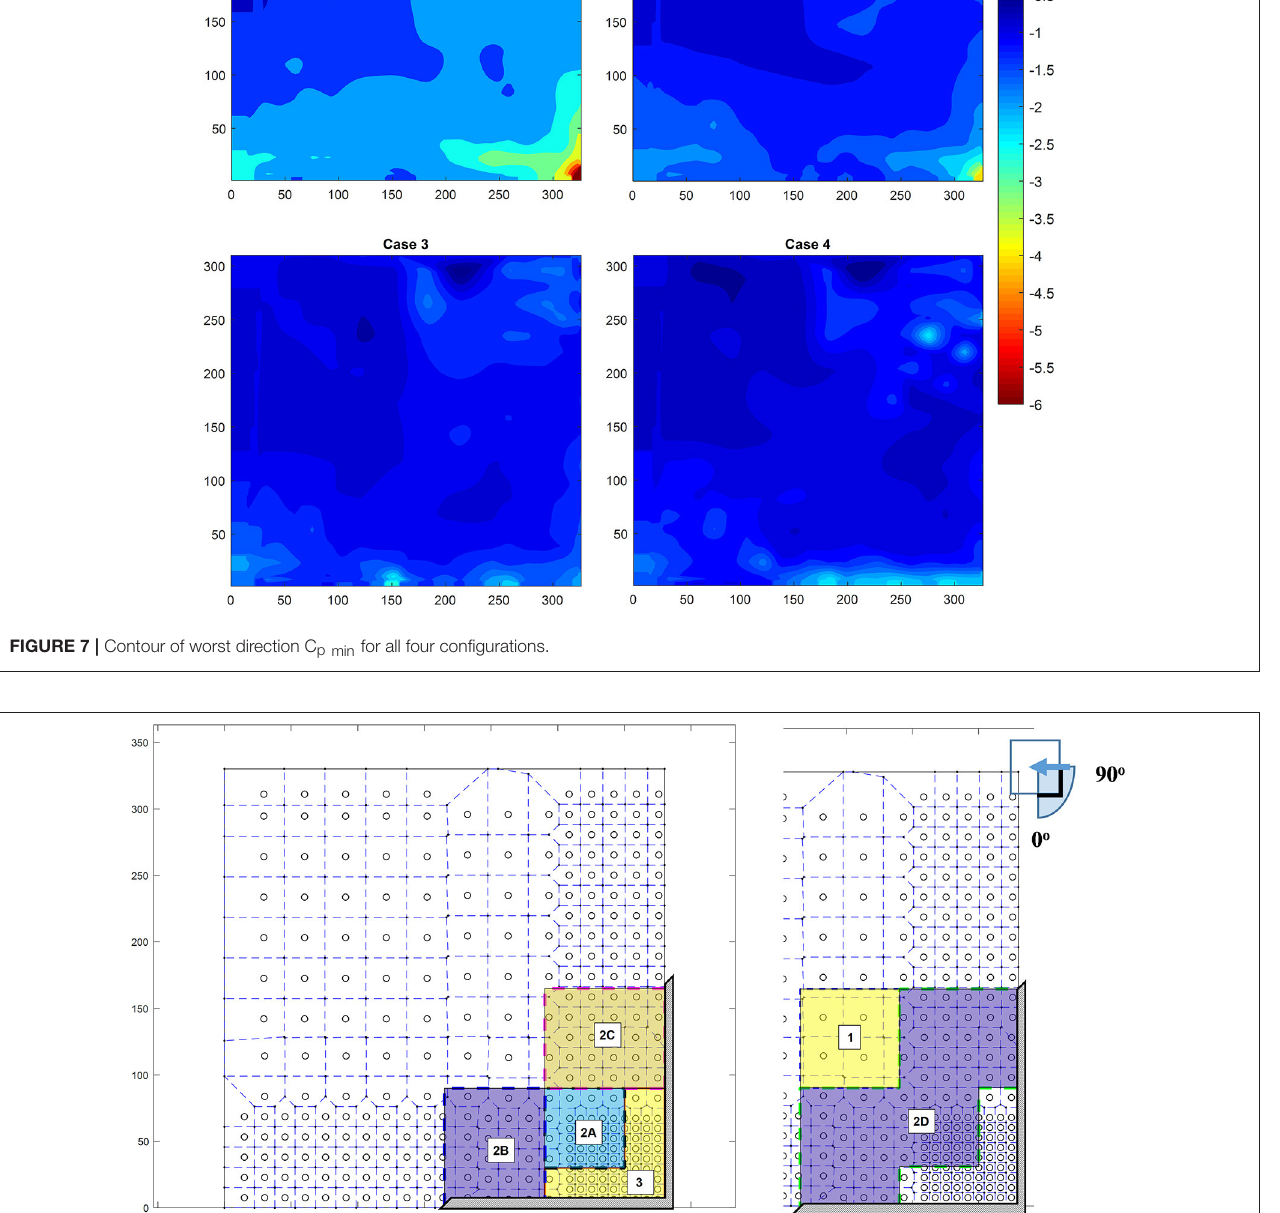
− 1.62 the highest change is observed in Case 3 with about 44% reduction. For the zone 2, the average percentage of peak pressure reduction is about 30% in Case 3, and for the same